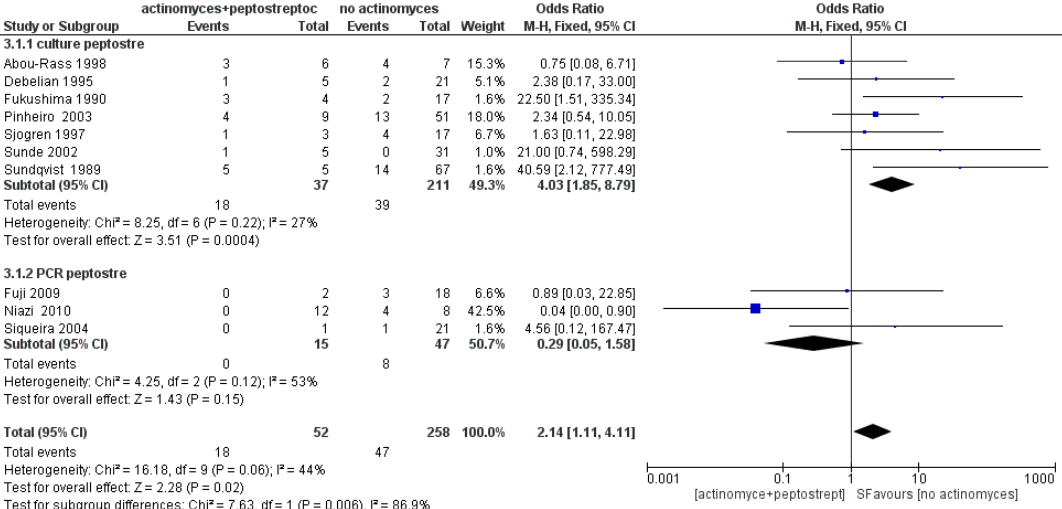
Figure 10. Forest plot of the fixed effects model of the meta-analysis of sub-group Peptostreptococci. Sub-group culture (OR = 4.03, 95% CI: [1.85, 8.79]), sub-group PCR (OR = 0.29, 95% CI: [0.05, 1.58]).